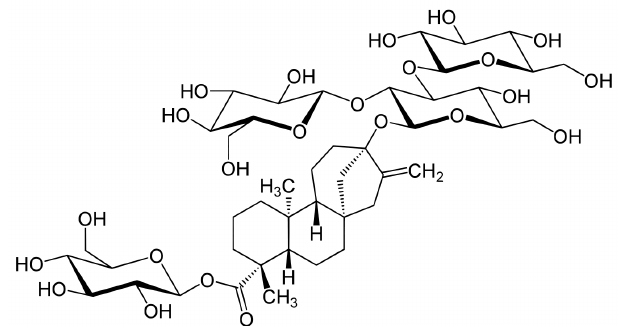
Fig. 9: Rebaudioside A, a steviol glycoside from Stevia